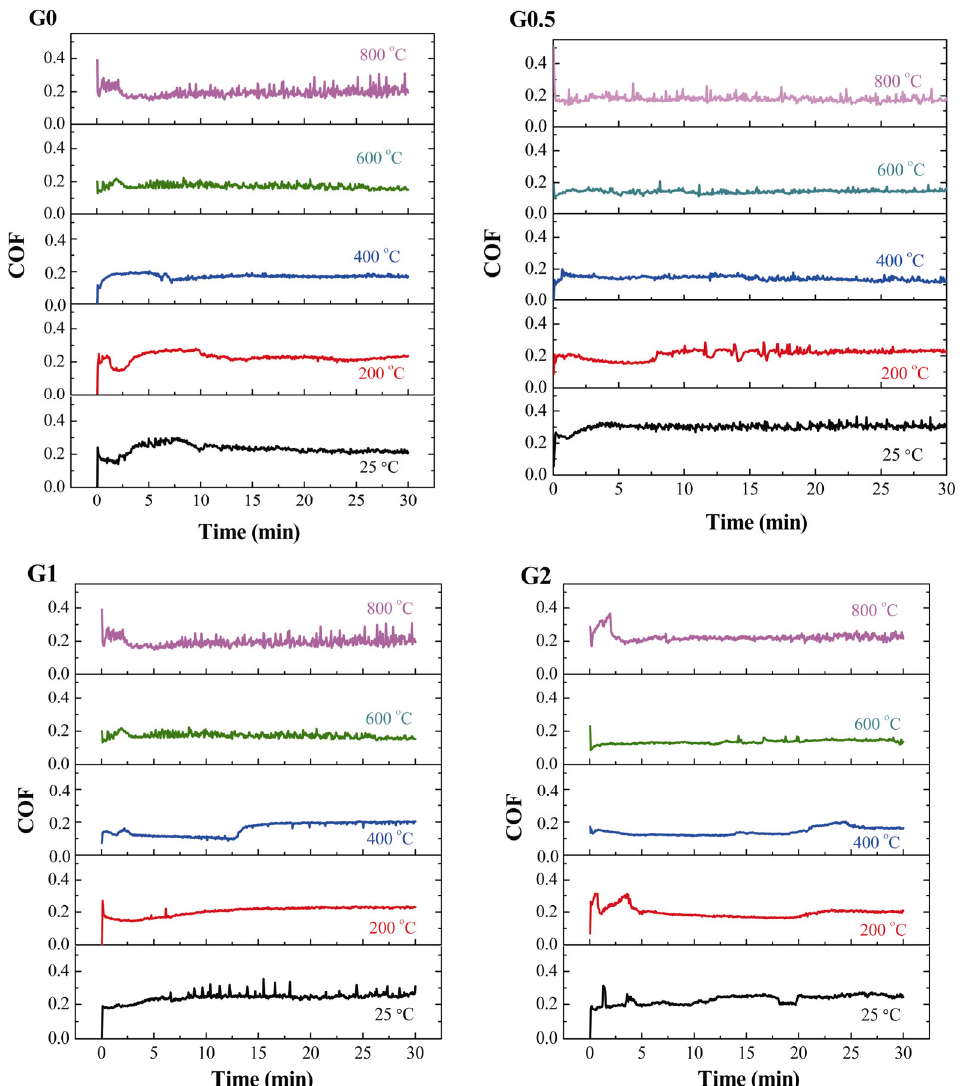
Fig. 5 Friction coefficients vs. sliding time curves for the composites at various temperatures in